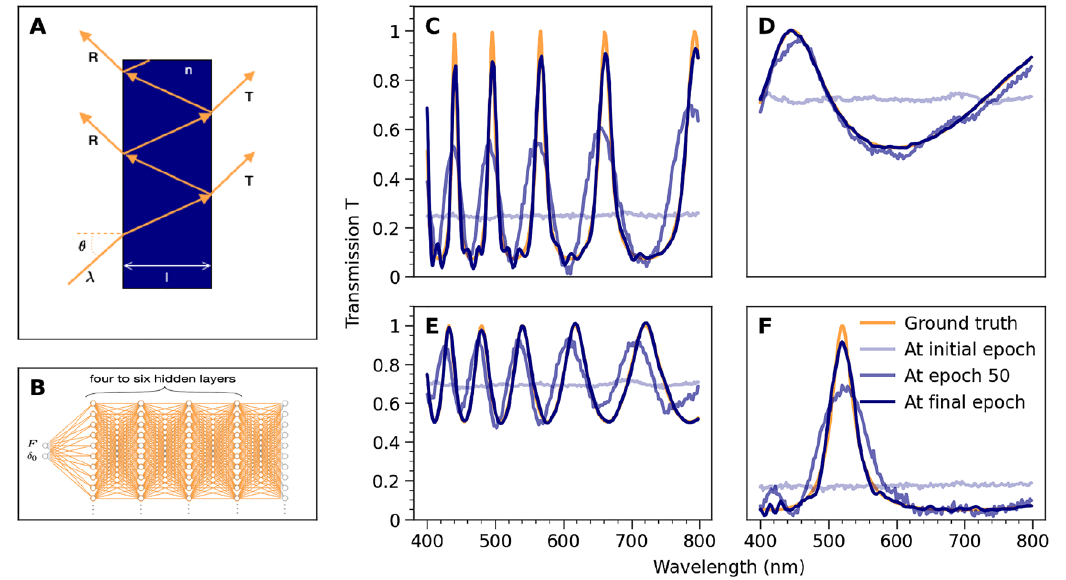
Figure 1: The first step of inverse design using deep learning. (A) A Fabry – Pérot resonator with refractive index n and width l . Multiple re fl ections inside the resonator cause interference between different outgoing waves, leading to non-trivial re fl ection and transmission spectra. (B) A neural network that maps the resonator parameters F and δ 0 to the wavelength-dependent transmission. The networks have four to six hidden layers. The networks we trained had 100 or 200 neurons in the hidden layers and 200 nodes in the output layer, each node corresponding to one wavelength between 400 and 800 nm. The parameters that are updated during training are highlighted in orange. (C) – (F) Predictions of transmissions T ( λ ) for different sets of material parameters. The orange lines show the analytically computed transmissions or ground truth. The blue lines show the predictions during training of the neural